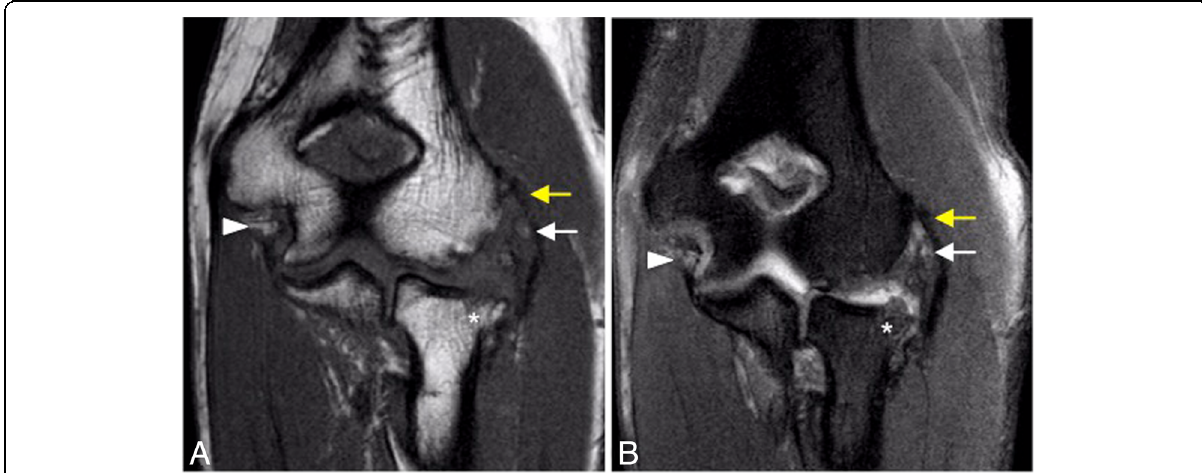
Fig. 31 Posterolateral rotatory instability, stage 3B. Coronal T1-weighted MRI ( a ) and coronal FS PD-weighted MRI ( b ) showing an acute proximal common avulsion of the lateral ulnar collateral ligament and radial collateral ligament (white arrows), an acute avulsion of the anterior bundle of the medial collateral ligament complex (white arrowheads), a radial head fracture (white asterisks), a partial tear of the proximal common extensor tendon (yellow arrows), and joint